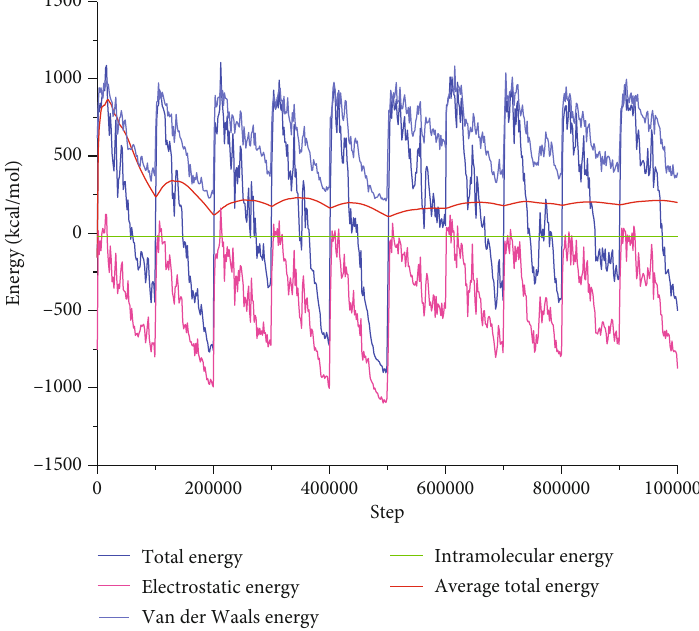
Figure 9: Energetic pro fi le of HydroTyr molecule during the Monte Carlo simulation under explicit solvation